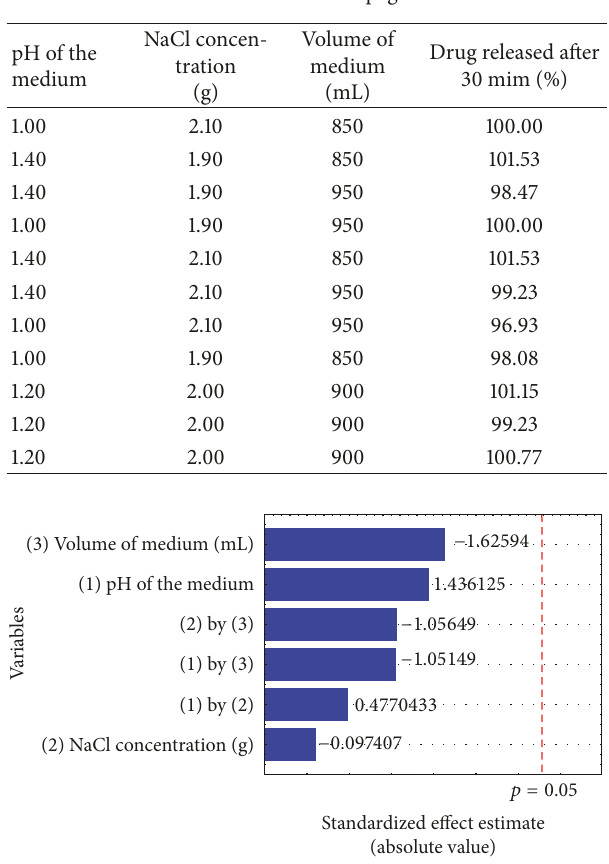
Table 1: Repeatability of the analytical method for the in vitro dissolution of dapagliflozin.